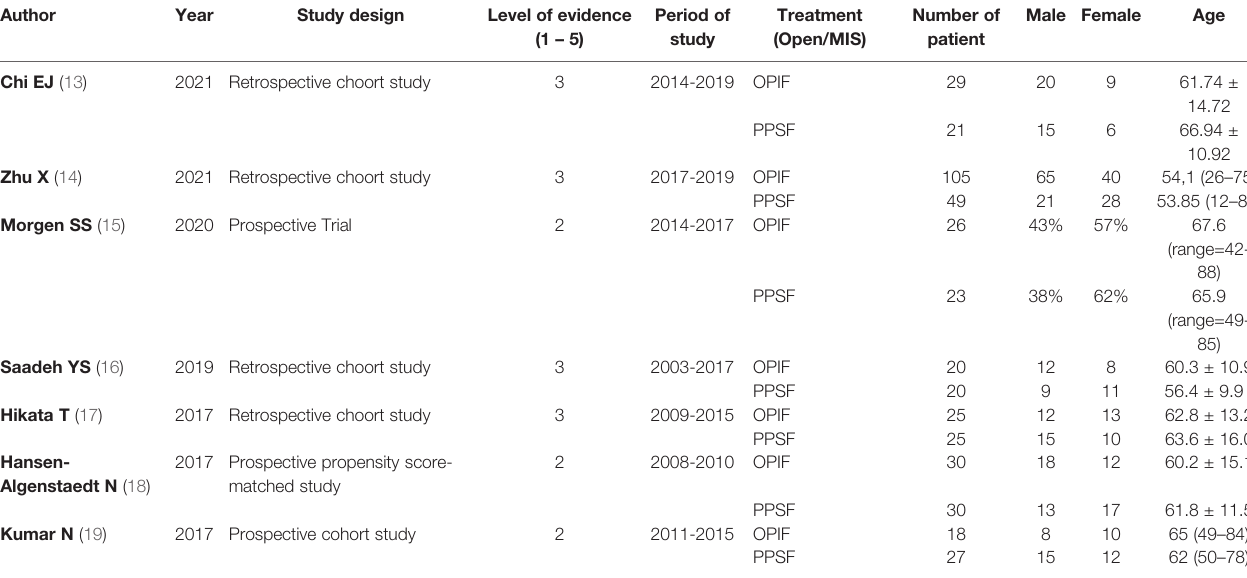
TABLE 3 | Baseline characteristics of the included studies; open posterior instrumented fusion (OPIF) and percutaneous pedicle screw fi xation